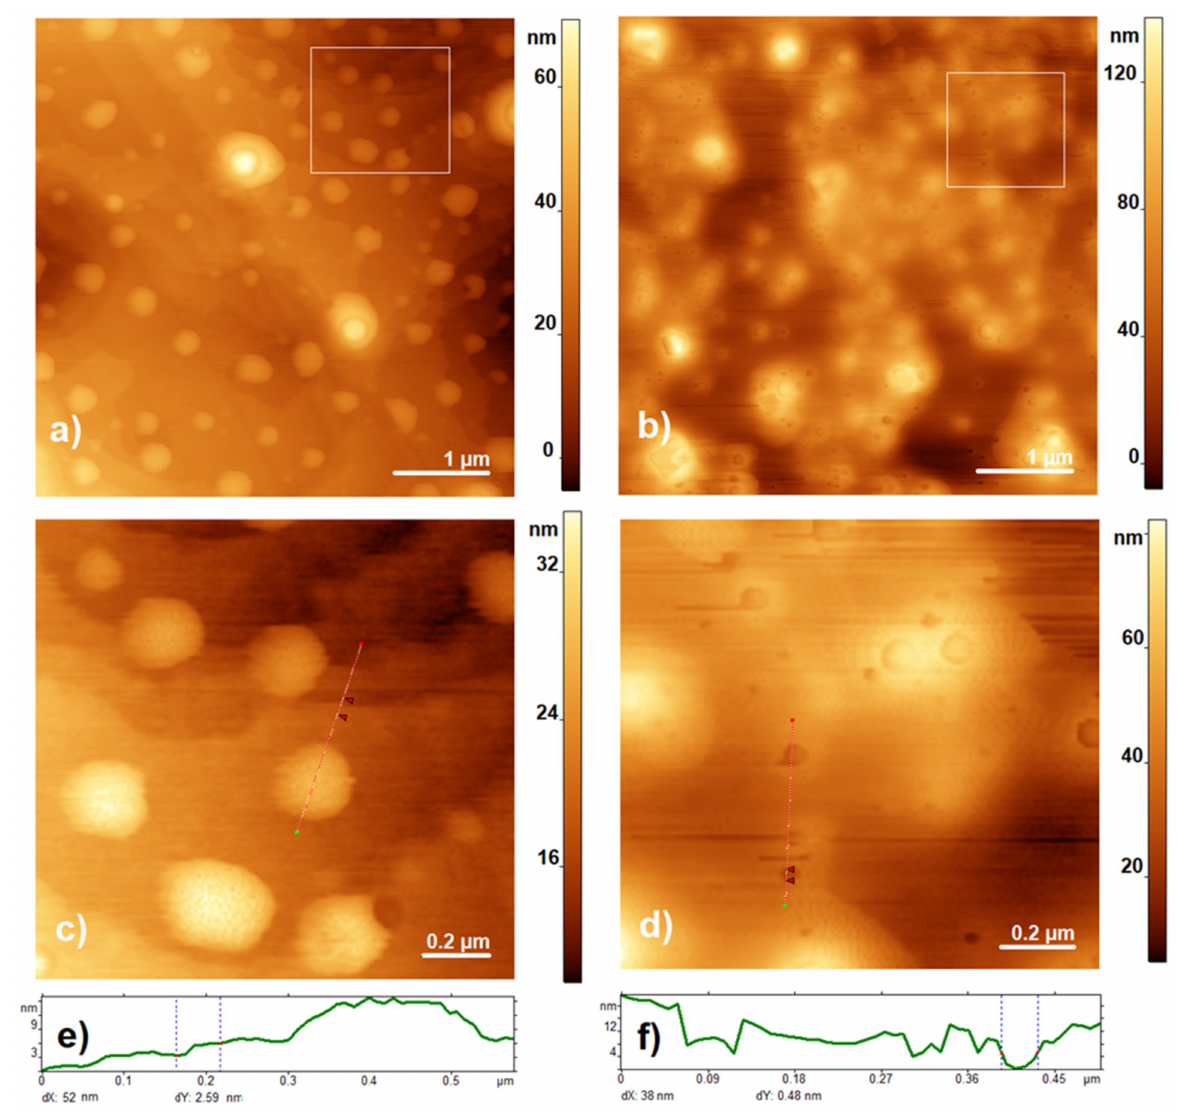
Figure 1. AFM images of DDAB (left column) and DDAB/SLO (right column). ( a , b ) Tapping mode height AFM images, ( c , d ) zoomed-in regions, shown by the white squares and ( e , f ) profiles along dotted lines with dX and dY measured between two red arrowhead